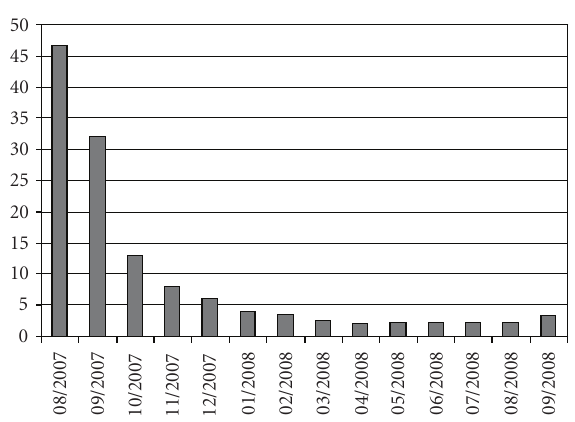
Figure 1: PSA course during trofosfamide